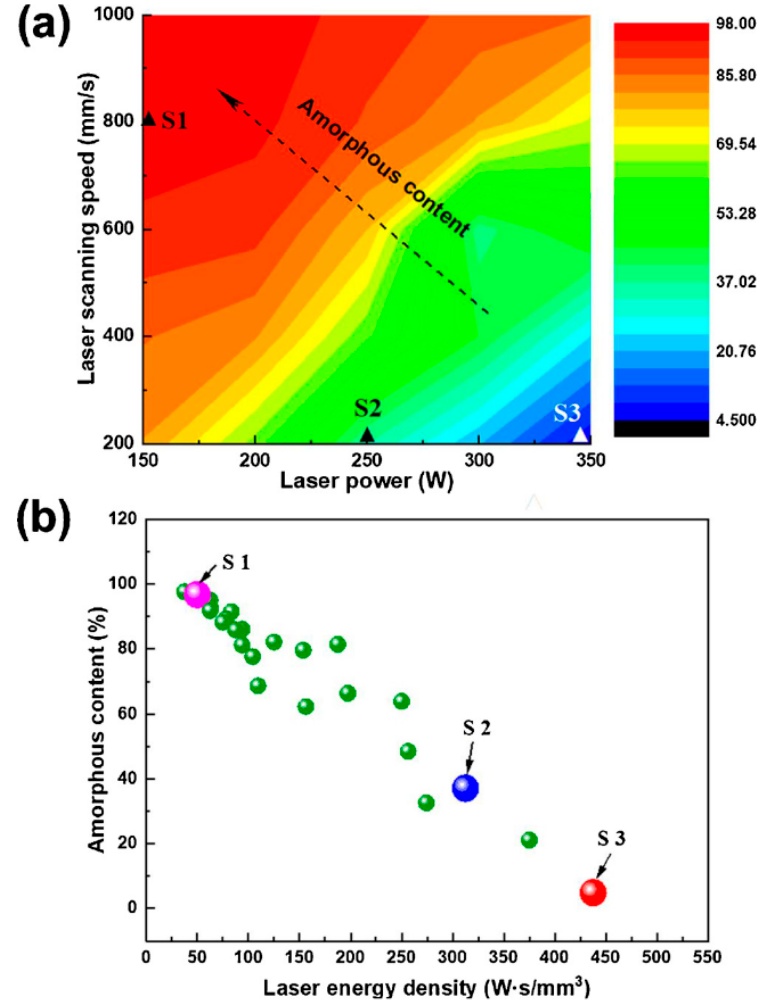
Figure 9. ( a ) Amorphous content of SLM Fe 43.7 Co 7.3 Cr 14.7 Mo 12.6 C 15.5 B 4.3 Y 1.9 glassy alloys, 3D-printed by using different laser powers and laser scan speeds. The data were interpolated between the measured data points. ( b ) The graph compares the laser energy density and amorphous content of SLM specimens, reprinted with the permission from [71], Elsevier, 2018 (S1, S2 and S3 have the laser energy densities of 36.8 J/mm 3 , 245.3 J/mm 3 and 343.3 J/mm 3 ).